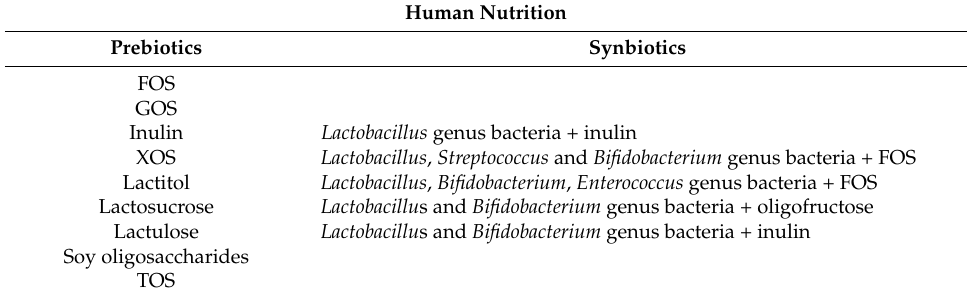
Table 4. Examples of prebiotics and synbiotics used in human nutrition